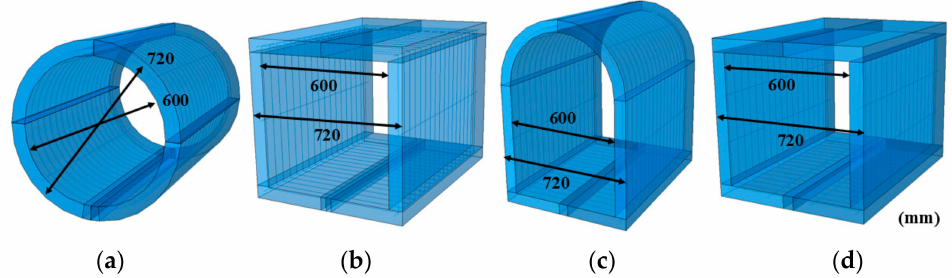
Figure 2. Geometric models of ( a ) Circular; ( b ) Rectangular; ( c ) Arched and ( d ) Cable trench type cable tunnels.